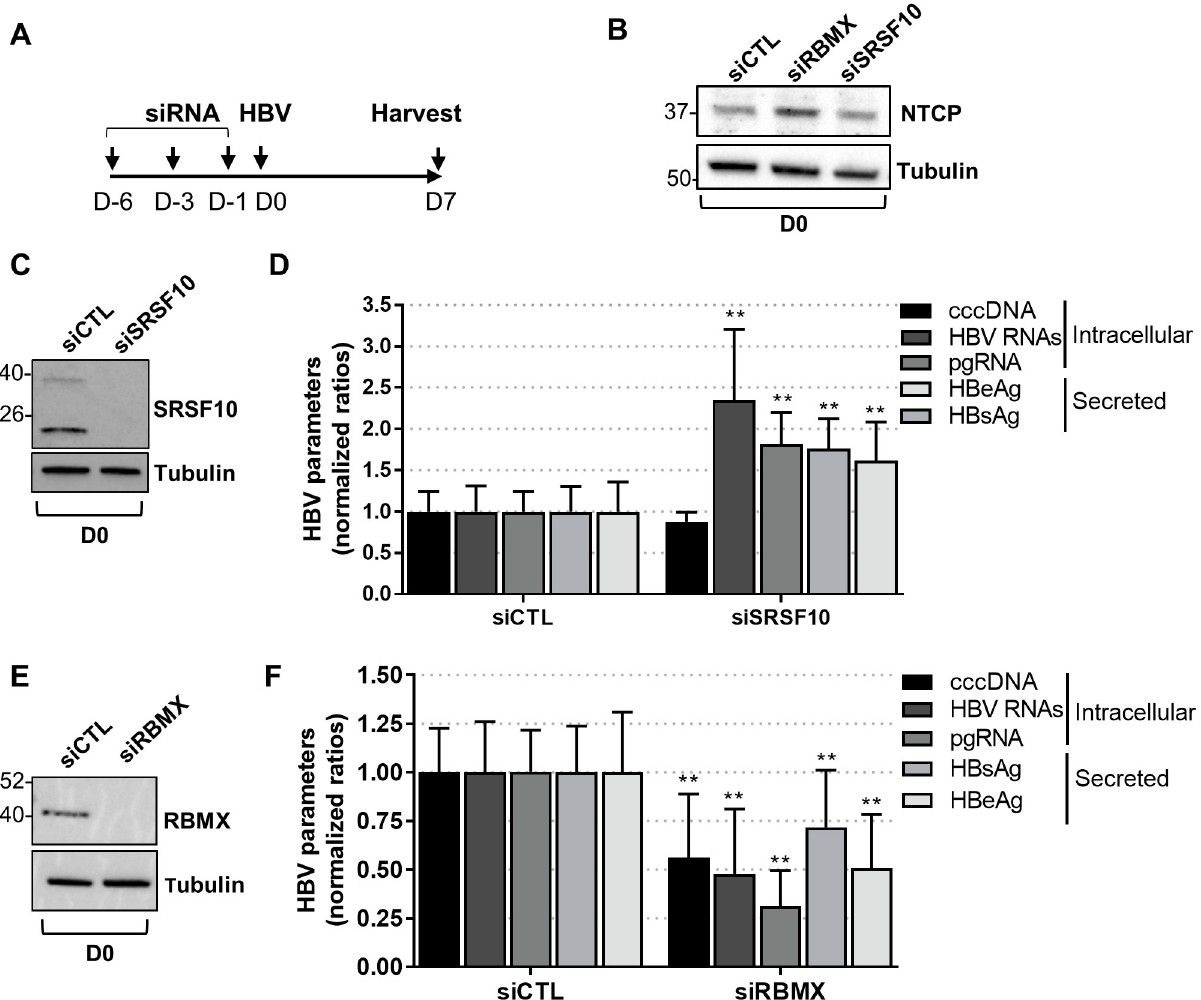
Fig 4. Effect of SRSF10 or RBMX KD on HBV replication in PHH. (A) Outline of the experimental protocol: cells were transfected with siRNA targeting SRSF10 or RBMX or control siRNA (siCTL) and then infected with HBV (MOI of 100 vge/cell). Cells and supernatants were harvested 7 days (D) post-infection (pi) and analyzed to measure intracellular and secreted HBV parameters. (B), (C) and (E) Western bot analysis of NTCP, SRSF10 and RBMX protein levels at D0 of the protocol, respectively. (D) and (F) HBV intracellular and extracellular parameters were measured at D7 pi. Results are expressed as the mean normalized ratio +/- SD, between siSRSF10 or siRBMX and siCTL transfected cells, of 3 independent experiments, each performed in triplicate, with PHH from different donors.